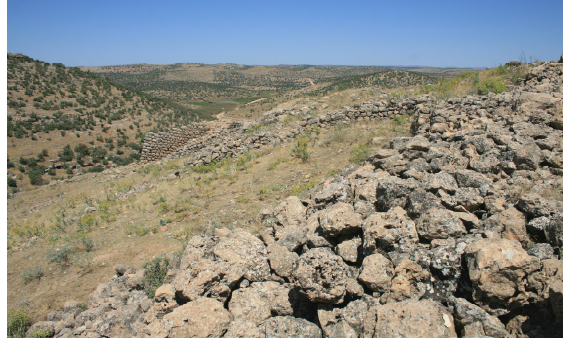
Fig. 10. Be ş ikkaya, a Roman-Byzantine curtain wall, view from SE to NW with the trapezoidal shaped tower in the background. Photo: Kenneth Silver